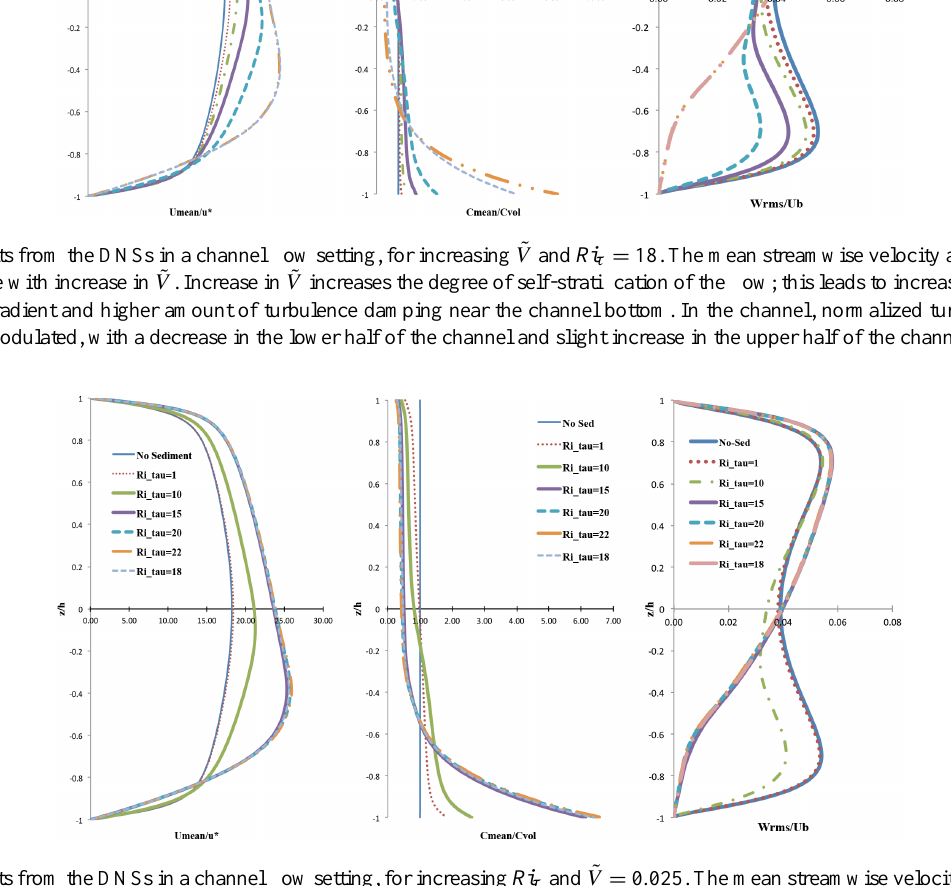
Figure 3. Results from the DNSs in a channel flow setting, for increasing Ri τ and ˜ V = 0 . 025. The mean streamwise velocity and asymmetry of the flow increase with increase in Ri τ . Increase in Ri τ increases the degree of self-stratification of the flow; this leads to increase in the sediment concentration gradient and higher amount of turbulence damping near the channel bottom. In the channel, normalized turbulence intensity ( W rms /U b ) is modulated, with a decrease in the lower half of the channel and slight increase in the upper half of the